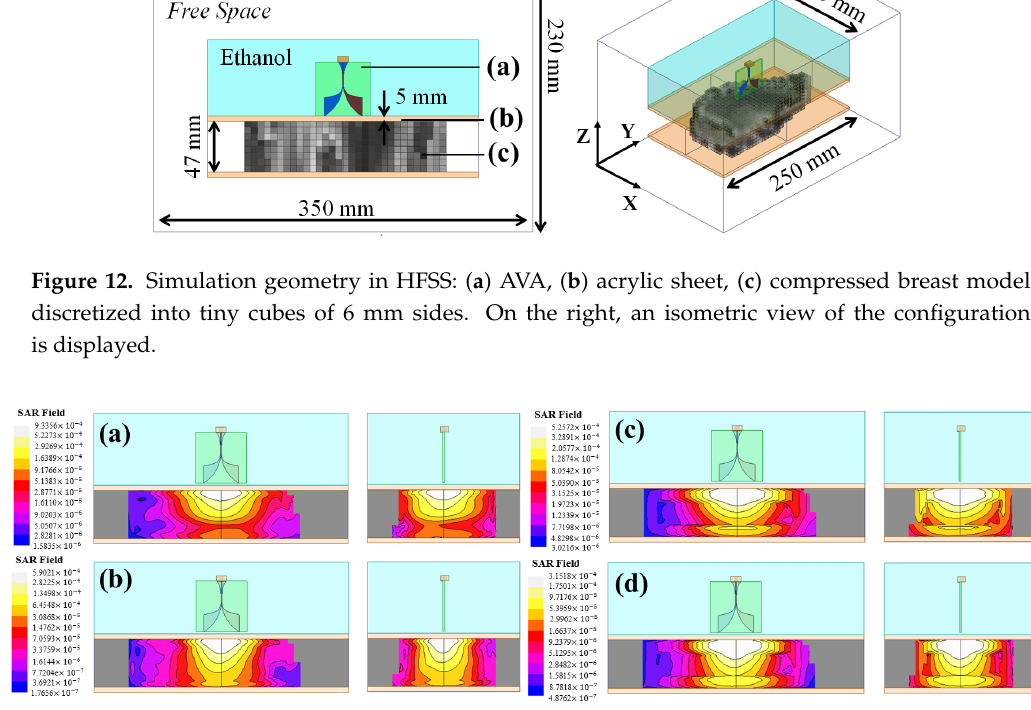
Figure 13. SAR analysis results with 1 g and 10 g samples at 1 GHz and 2.5 GHz: ( a ) 1 g at 1 GHz, ( b ) 1 g at 2.5 GHz, ( c ) 10g at 1 GHz, ( d ) 10 g at 2.5 GHz. The peak SAR is much smaller than the US (EU) standard, 1.6 W/Kg (2 W/Kg), in all